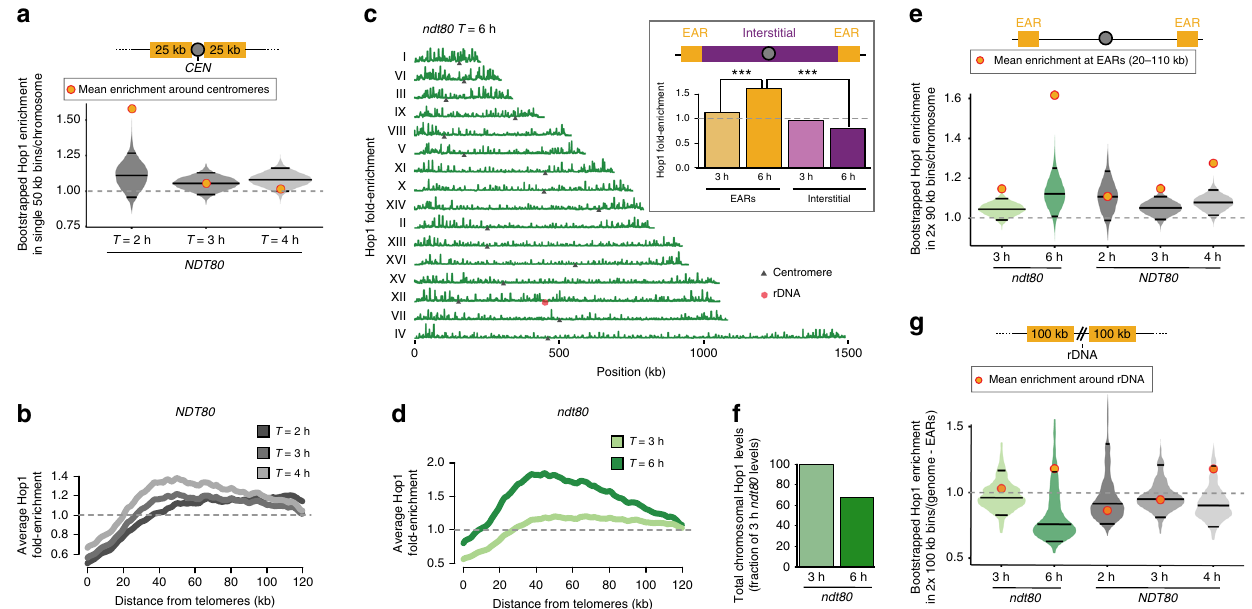
Fig. 2 Hop1 enrichment in EARs, centromere-proximal and rDNA-proximal regions during prophase. a Time series of Hop1 enrichment around centromeres (50 kb) in NDT80 . Bootstrap-derived distributions within single 50-kb bins per chromosome are shown as violin plots and the horizontal lines within the plots represent the median and the two-ended 95% CIs. The mean Hop1 ChIP-seq enrichment around centromeres (50 kb centered around centromeres) is shown as orange/red dots. b Mean Hop1 enrichment in the EARs (32 domains) is plotted as a function of distance from telomeres in NDT80 . The gray dashed line is genome average. c Hop1 ChIP-seq enrichment (dark green) in ndt80 Δ -arrested late prophase cells plotted along each of the 16 yeast chromosomes; black triangles mark the centromeres and the red hexagon marks the rDNA locus. The data are normalized to a global mean of 1. Inset shows mean enrichment in EARs (20 – 110 kb, orange) and interstitial chromosomal regions (magenta) in early prophase ( T = 3 h) and extended prophase ( T = 6h). *** P <0.001, Mann-Whitney-Wilcoxon test. d Mean Hop1 enrichment in the EARs (32 domains) is plotted as a function of distance from telomeres in ndt80 Δ cells. e Bootstrap-derived distributions within two 90-kb bins per chromosome from Hop1 ChIP-seq data depicted as violin plots. The horizontal lines in the violin plots represent the median and the two-ended 95% CIs. The mean Hop1 ChIP-seq enrichment in EARs (20 – 110kb) for the respective samples is shown as orange/red dots. f Spike-in normalized total chromosomal Hop1 levels in ndt80 Δ samples during extended prophase ( T = 6h) compared to early prophase ( T = 3 h). g Bootstrap-derived distributions within two 100-kb bins per genome from Hop1 ChIP-seq data illustrated as violin plots. The horizontal lines in the violin plots represent the median and the two-ended CIs. The mean Hop1 ChIP-seq enrichment in rDNA-adjacent domains (100 kb on either side of the rDNA) for the respective samples is shown as orange/red